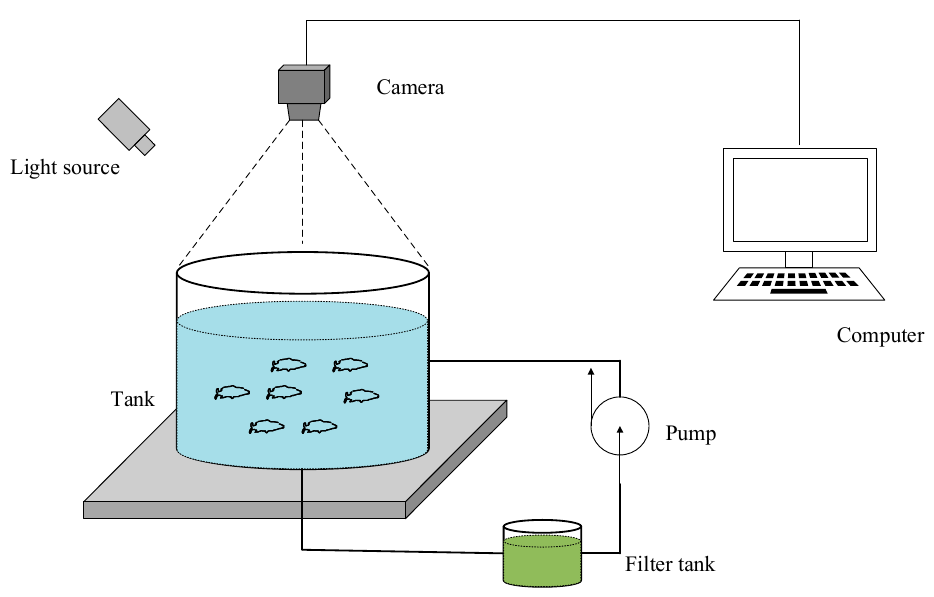
Figure 1. The layout of the experimental scene.